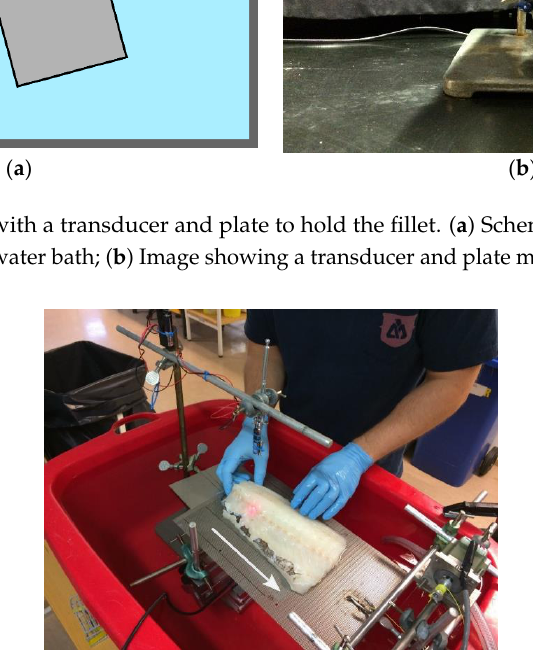
Figure 3. Complete setup placed in a plastic tub for immersion in water. The fish fillet in placed on a